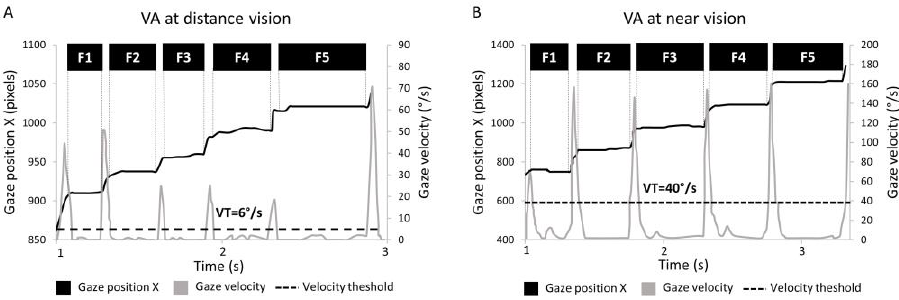
Figure 2. Fixation classification examples from a gaze position signal during VA test at distance vision ( A ) and near vision ( B ). The velocity threshold was set to allow the algorithm to recognize the five fixations corresponding to the five optotypes displayed on the screen (F1–F5).